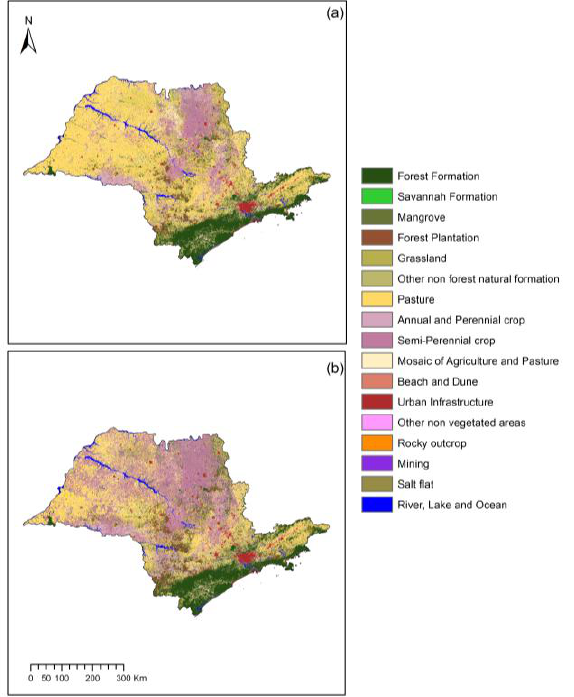
Figure 2. Land cover of the São Paulo State in years 2000 (a) and 2015 (b) according to the classification scheme of Figure 1. Location of São Paulo State of Brazil in the context of MapBiomas Project - Collection 4 South America Description of the land cover categories that occurred in São Paulo State in these years, their respective ID’s and legend colors are described in Table 1. Detailed information about classification methodology and datasets can be found in